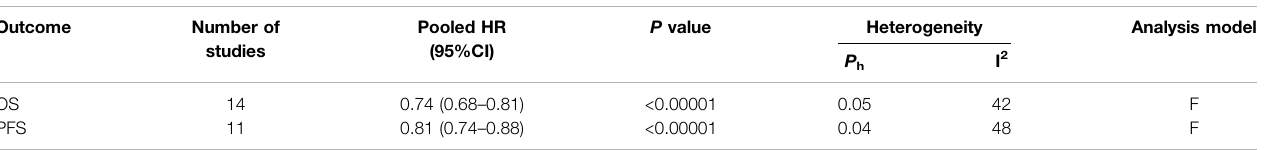
TABLE 4 | Meta-analysis on survival outcomes.